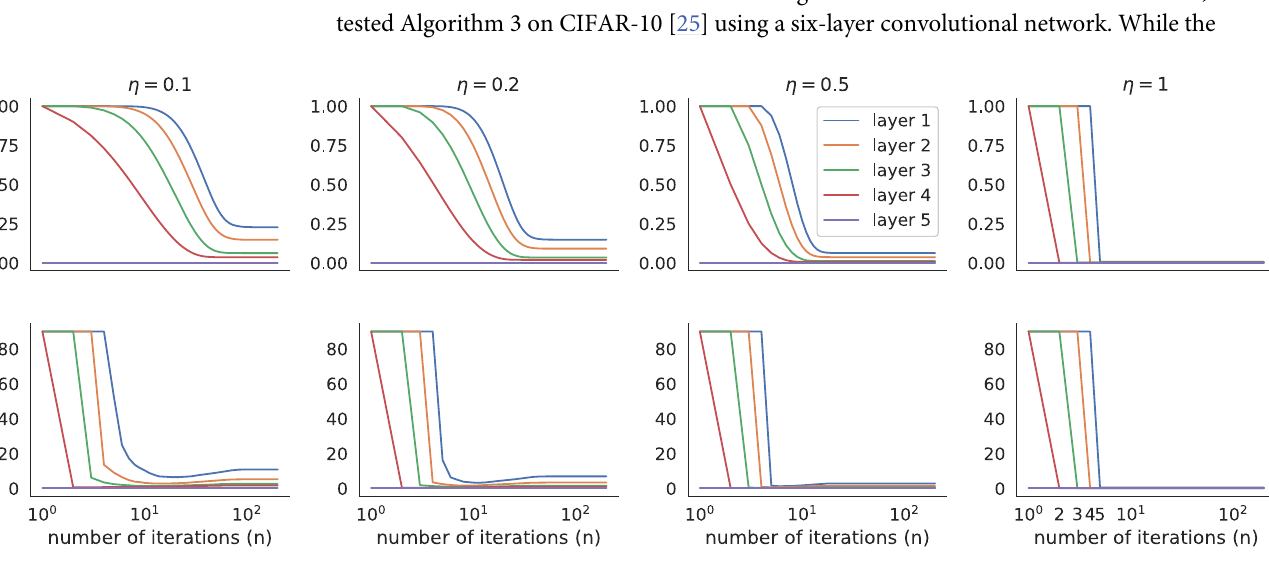
PLOS ONE | https://doi.org/10.1371/journal.pone.0266102 March 31,